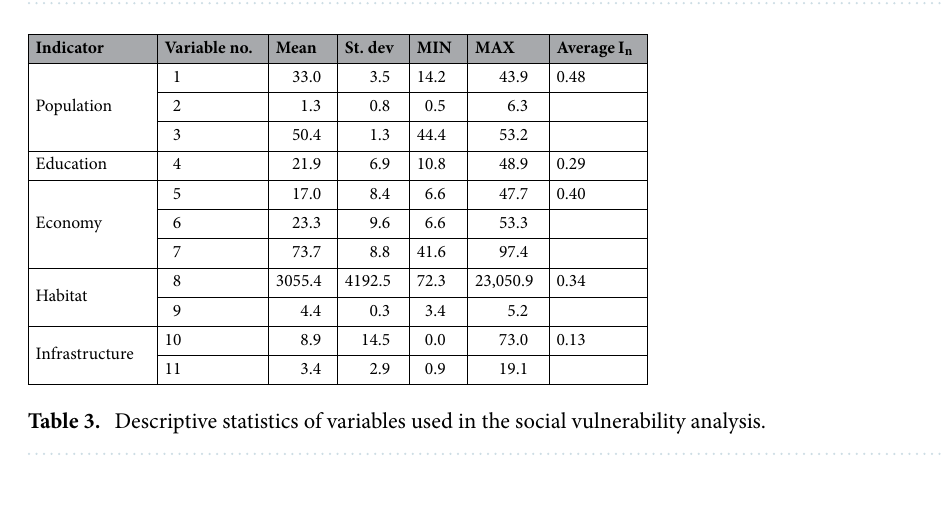
Figure 5. ( a ) Observed; and ( b ) Predicted urbanization maps of Kathmandu Valley for 2021.